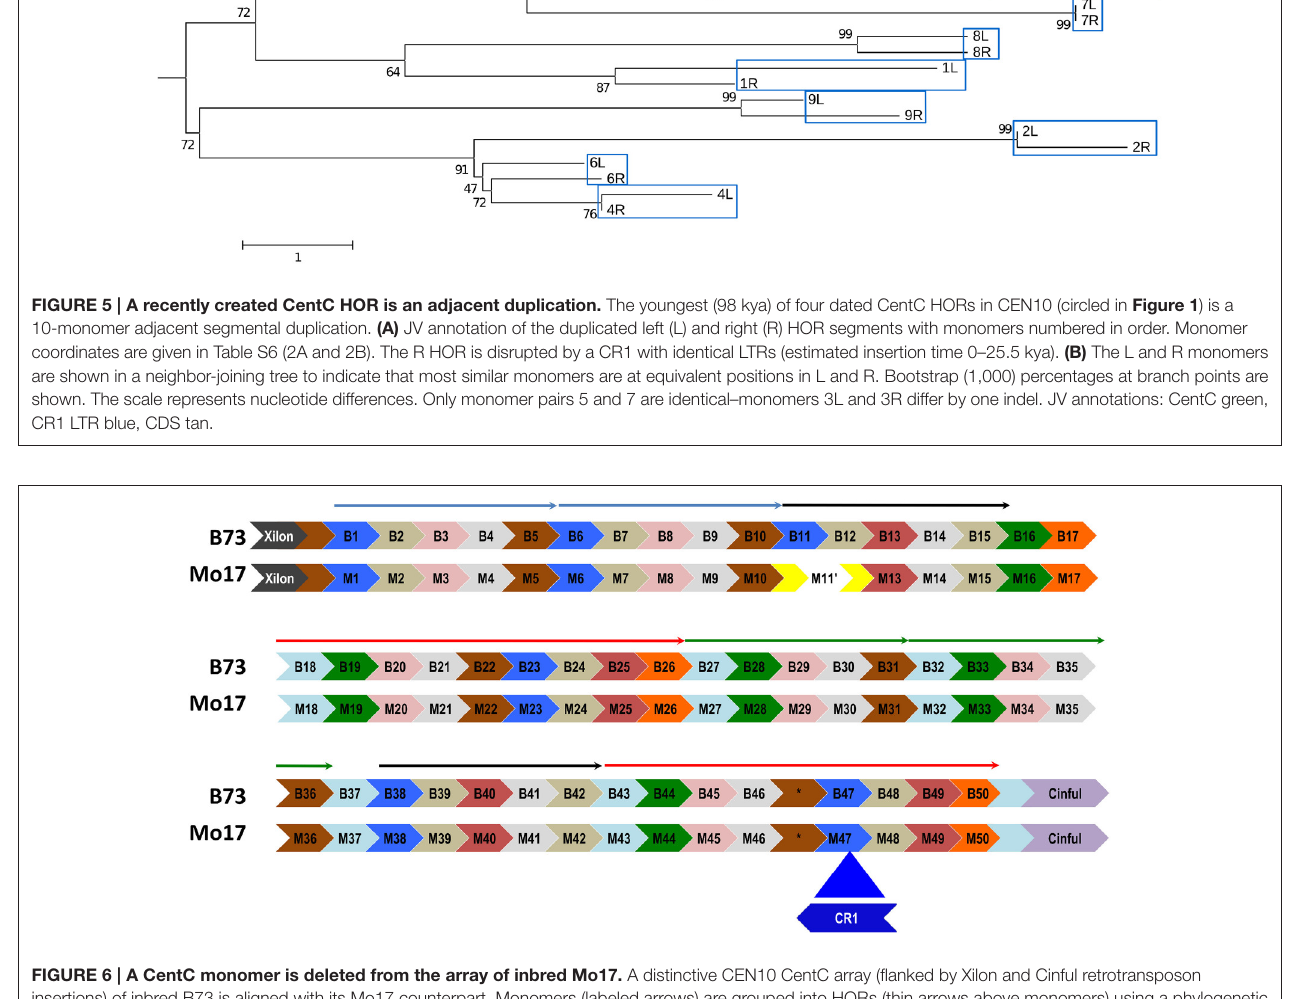
FIGURE 6 | A CentC monomer is deleted from the array of inbred Mo17. A distinctive CEN10 CentC array (flanked by Xilon and Cinful retrotransposon insertions) of inbred B73 is aligned with its Mo17 counterpart. Monomers (labeled arrows) are grouped into HORs (thin arrows above monomers) using a phylogenetic tree (Figure S8). Part of the first black HOR is missing in Mo17, where a chimeric monomer (M11 ′ ) resulted from a deletion of the 3 ′ M11 and 5 ′ M12 monomers. This deletion was mediated by a region of 28 identical nucleotides present in B73 monomers B11 and B12 (Figure S7). The Mo17 CentC array includes a CR1 insertion into M47 that disrupts the second red HOR and is absent in the B73 array. The Mo17 segment downstream of the CR1 insertion to the Cinful element was confirmed by PCR amplification and sequencing. One CentC sequence ( * ) similar to the other brown monomers contains a 40-nt insertion in both inbreds. The youngest (blue) and oldest (green) HORs date to 131 kya and 297 kya, respectively. Potentially recombinant monomers at the ends of HORs were excluded from the alignment used to date the duplication